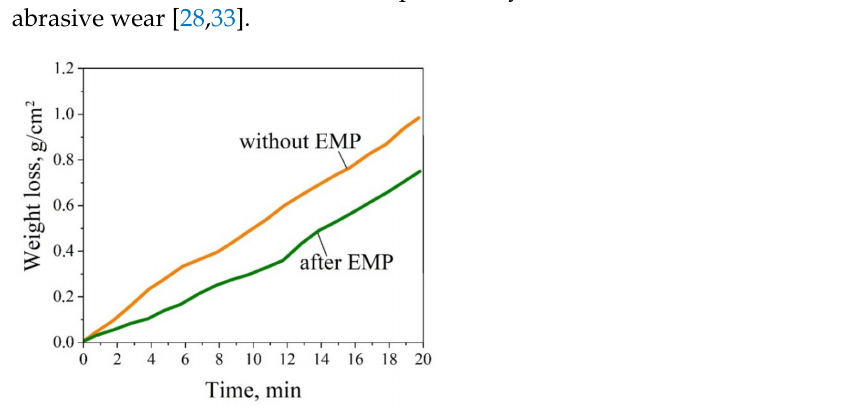
Figure 6. Weight loss of Al 0.25 CoCrFeNiV HEA as a function of exposure time to the flow of abrasive